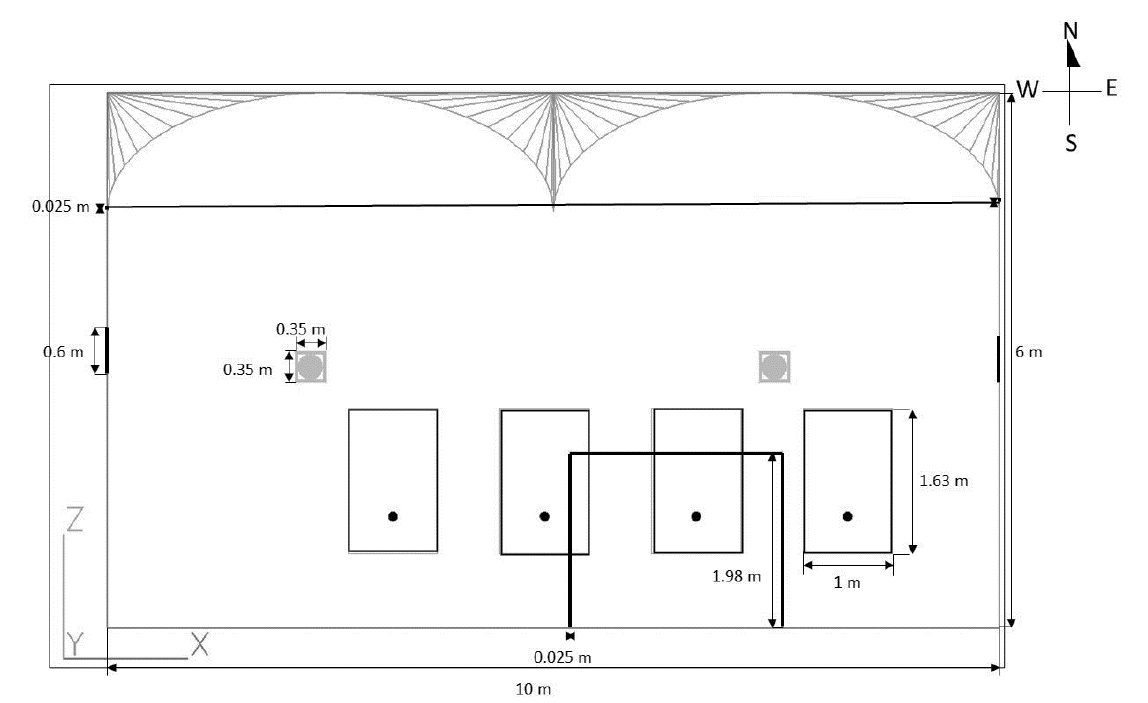
Figure 6. Greenhouse model: (the squares represent fan circulator, rectangular shapes represent the plants, the circles represent CO 2 perforated tube, and the thick lines and dots represent outlet).